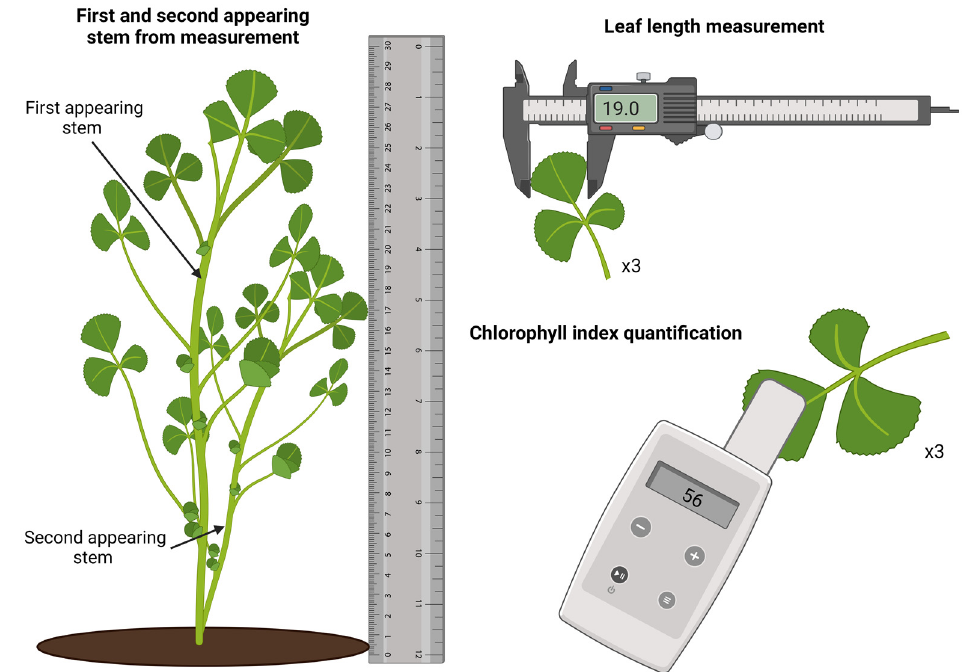
Figure 9. Measurement tools and proceedings for quantifying stem length, leaf length, and chlorophyll index.